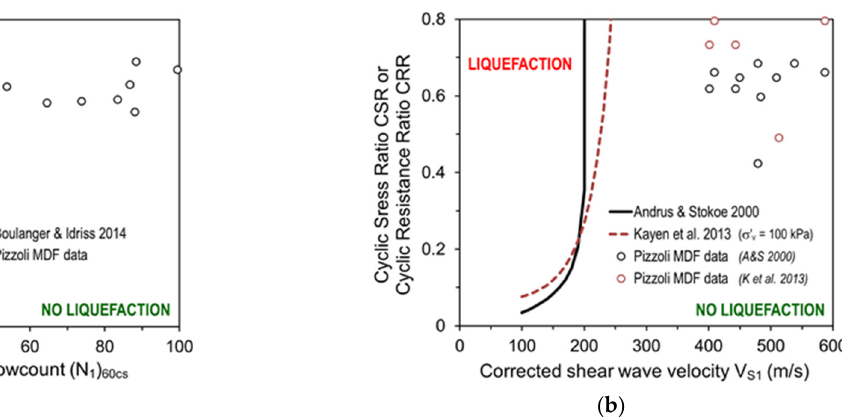
Figure 18. Results of liquefaction assessment using simplified methods based on SPT ( a ) and V S ( b ). Boulanger & ldriss 2014 [103]; Andrus & Stokoe 2000 [104]; Kayen et al. (2013)